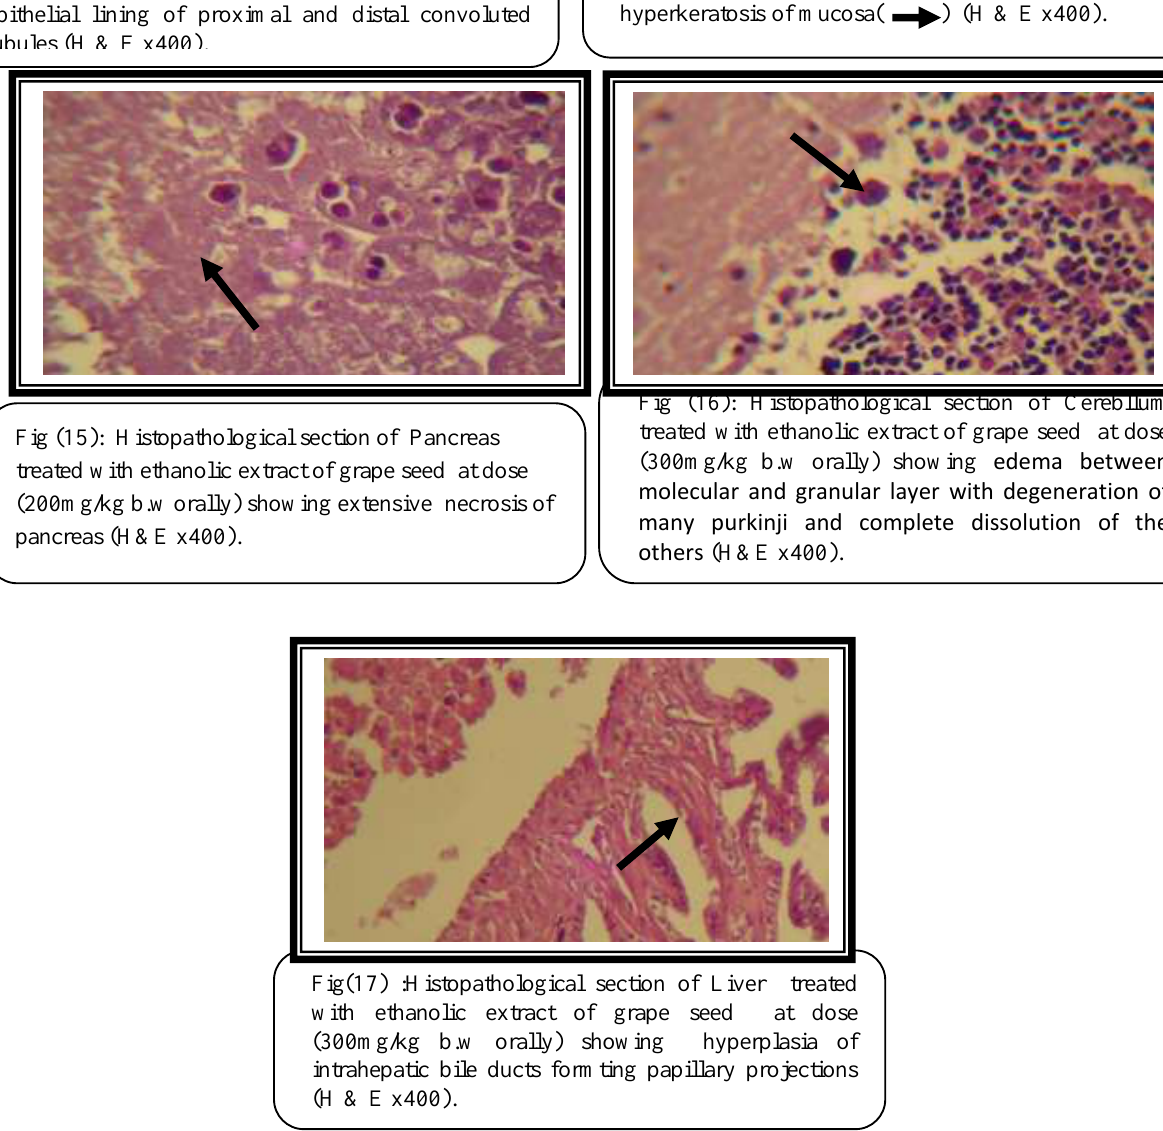
Fig(14) :Histopathological section of Stomach treated with ethanolic extract of grape seed at dose (200mg/kg b.w orally) showing hyperplasia( )and marked hyperkeratosis of mucosa( ) (H & E